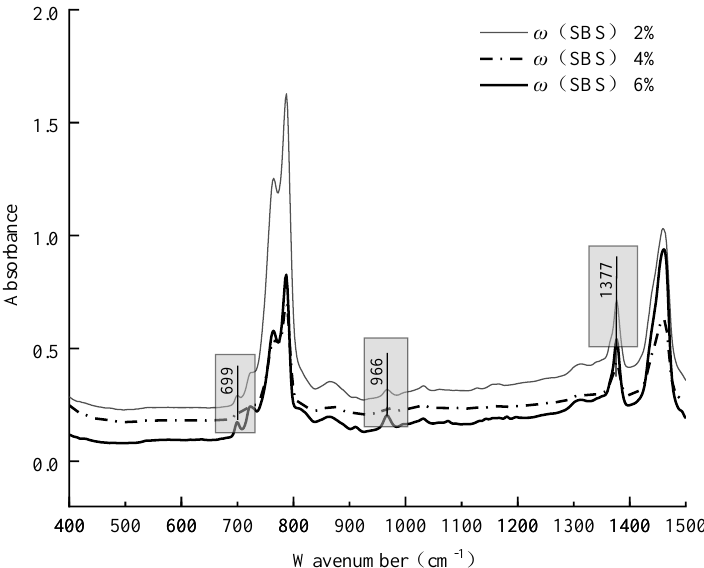
Figure 5. Infrared spectrum of SBS modified asphalt with different SBS content.